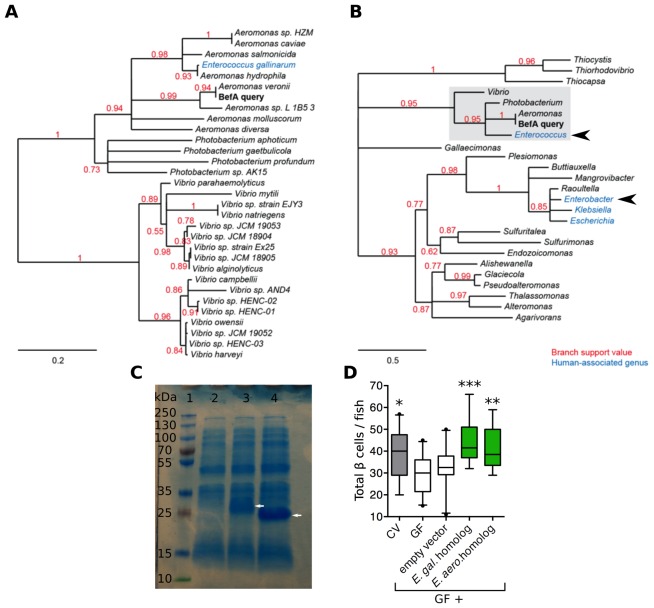
Homologs of BefA encoded in the human microbiome have conserved function in zebrafish.(A) Close homologs of BefA across microbial species. Each species is represented by its closest BefA homolog, with a minimum allowed amino acid sequence identity of 50% (relative to the query sequence). Notably, the Enterococcus gallinarum homolog clusters among homologs from the Aeromonas genus, which is evidence of a possible lateral gene transfer event. (B) A view of the BefA phylogeny including more distant homologs (sequence identity >20%) and grouped by genus. The portion of the tree represented in A is contained in the light gray box. In both panels, red numbers indicate branch support (values closer to 1 are better supported); branches with support values <0.5 have been collapsed. Blue clades indicate genera that were associated with humans in metagenomes produced during the Human Microbiome Project (HMP). Black arrowheads indicate genera tested for functional conservation in panel D. Scale bars indicate amino acid substitutions per amino acid site. (C) SDS-page gel: 1 = ladder, 2 = CFS from induction of E. coli BL21 carrying an empty vector, 3 = CFS from induction of E. coli BL21 carrying vector with an Enterococcus gallinarum homolog, estimated size of 29 kDa, lane 4 = CFS from induction of E. coli BL21 carrying vector with Enterobacter aerogenes homolog, estimated size of 21 kDa. White arrows indicate induced proteins. (D) Total β cells in CV, GF and GF fish that have been treated with either induced BL21 E. coli supernatant dominated by the homologous BefA protein encoded from Enterococcus gallinarum (E. gal. homolog) and Enterobacter aerogenes (E. aero. homolog), or induced supernatant from an empty vector control. *p<0.05, **p<0.01, ***p<0.001: Denotes treatment that is significantly different than GF by Tukey analysis.DOI:
http://dx.doi.org/10.7554/eLife.20145.01910.7554/eLife.20145.020Figure 6—source data 1.Quantifications and statistical analysis of larval β cells corresponding to Figure 6D.Exact values of N, mean, median, SD, and SEM are reported in the source data file and are highlighted in yellow, magenta, blue, green, and cyan, respectively.